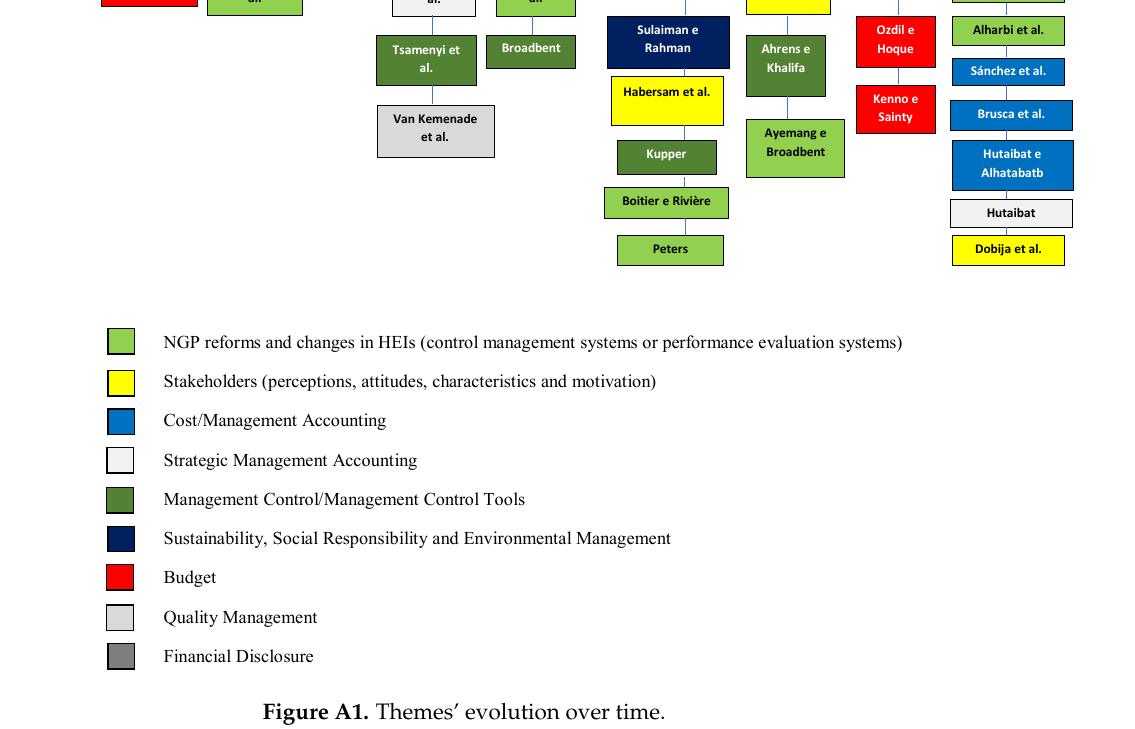
Figure A1. Themes’ evolution over